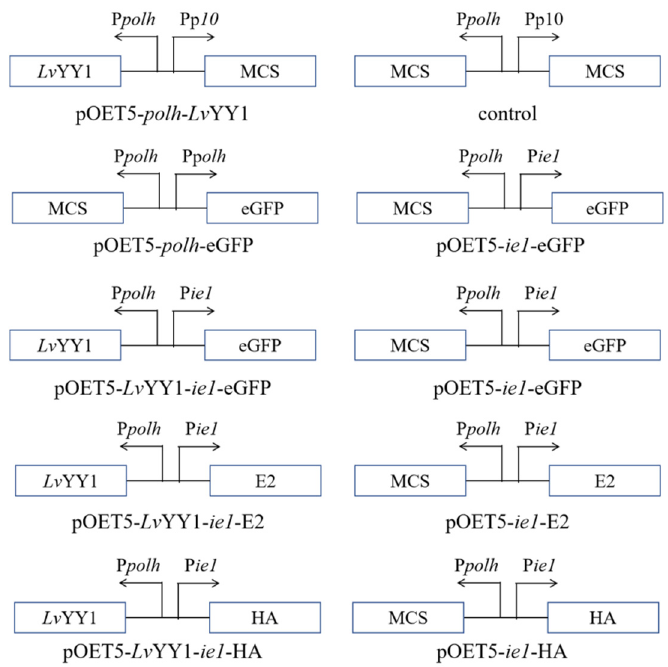
Figure 1. Schematic diagram of donor vectors of recombinant baculoviruses. Arrows indicated the direction of the promoters to drive the protein expression. ie1 : WSSV immediate-early one promoter, Lv YY1: Litopenaeus Vannamei Yin Yang 1, MCS: multiple cloning sites, polh : AcMNPV polyhedrin promoter, p10: AcMNPV p10 promoter, eGFP: Enhanced Green Fluorescent Protein, E2: Glycoprotein E2 of CSFV, HA: Hemagglutinin of